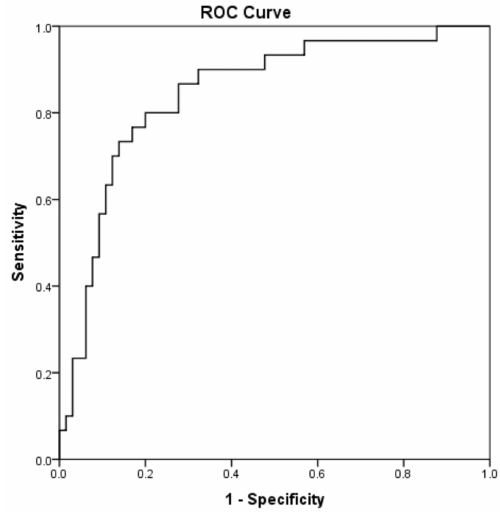
Figure 2. Receiver operating characteristic (ROC) curve analysis. A ROC curve was generated to determine the prognostic accuracy of suPAR on hospital admission (within 24 h). suPAR gave an AUC of 0.81 (0.71–0.91), p < 0.0001, at a cut-off value of 6.31 ng/mL, with greatest combined sensitivity of 74.2% and specificity 85.9% suPAR = soluble urokinase-type plasminogen activator receptor. Patients with lower (low group = 0) than the cut-off value generated from the ROC curve, were subsequently compared to the patients who had higher than the cut-off value (high group = 1). We found that the higher group was associated with a higher overall mortality in the Kaplan-Meier analysis. The respective median time to mortality for the aforementioned groups was 37 (23–51) days for the low group, and 25 (22–28) days for the high group (Log-Rank test, p = 0.006; Figure 3).